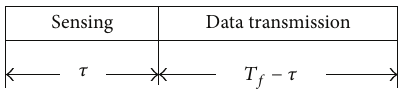
Figure 1: Frame structure of the cognitive radio